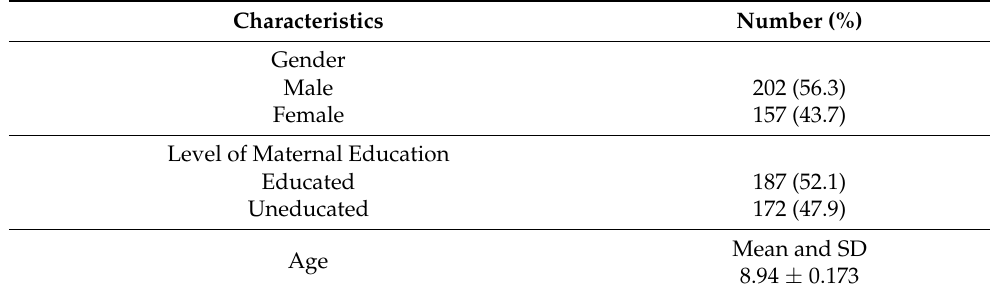
Table 1. Distribution of demographic characteristics ( n = 359).